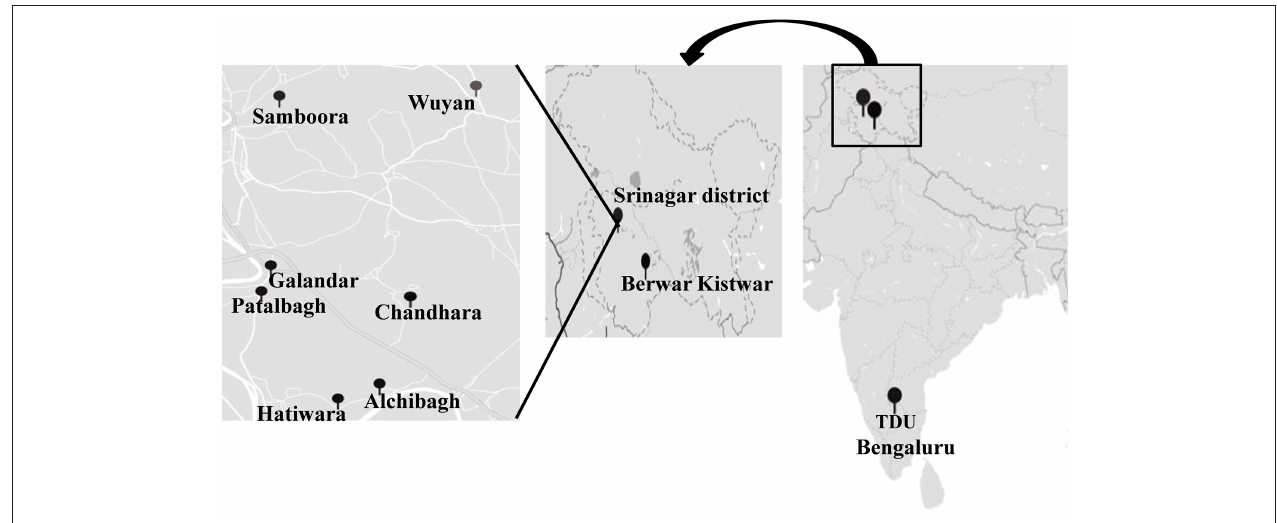
FIGURE 1 | Geographic location of sample collection sites on the map of India. TDU (The University of Trans-Disciplinary Health Sciences and Technology), Bengaluru, (Berwar) Kishtwar and 8 locations with in Srinagar district (Wuyan, Patalbagh_upper range, Patalbagh_lower range, Alchibagh, Galandar, Chandhara, Hatiwara and